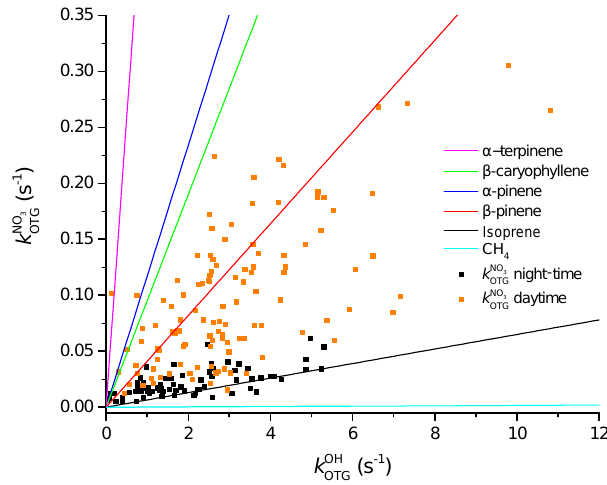
Figure 11. Correlation between OH reactivity and NO 3 reactivity. The coloured lines are relative NO 3 and OH reactivity for single VOCs. The measured NO 3 and OH reactivities are depicted as black (night-time) and orange data points